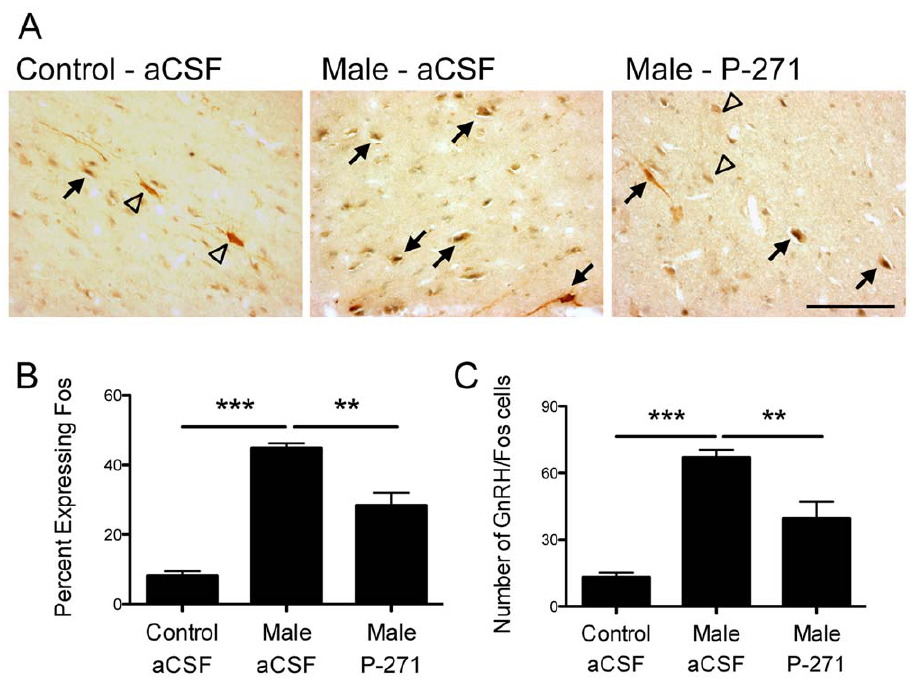
Figure 4. Male exposure in anestrous ewes resulted in Fos induction in GnRH neurons. A, Bright-field photomicrographs indicate GnRH (brown) and Fos (black) neurons ( arrows ) in the mPOA. Single labled GnRH neurons are indicated by open triangles . Scale bar , 100 m m. B–C, The percentage of GnRH neurons co-expressing Fos and the number of GnRH/Fos neurons was greater in male exposed ewes compared to ewes not exposed to males (Control – aCSF). Kisspeptin antagonist treatment (P-271) reduced the percentage and number of GnRH cells co-expressing Fos in male exposed ewes. Data are the mean 6 SEM, ***P , 0.001, **P , 0.01, n=4 per group.